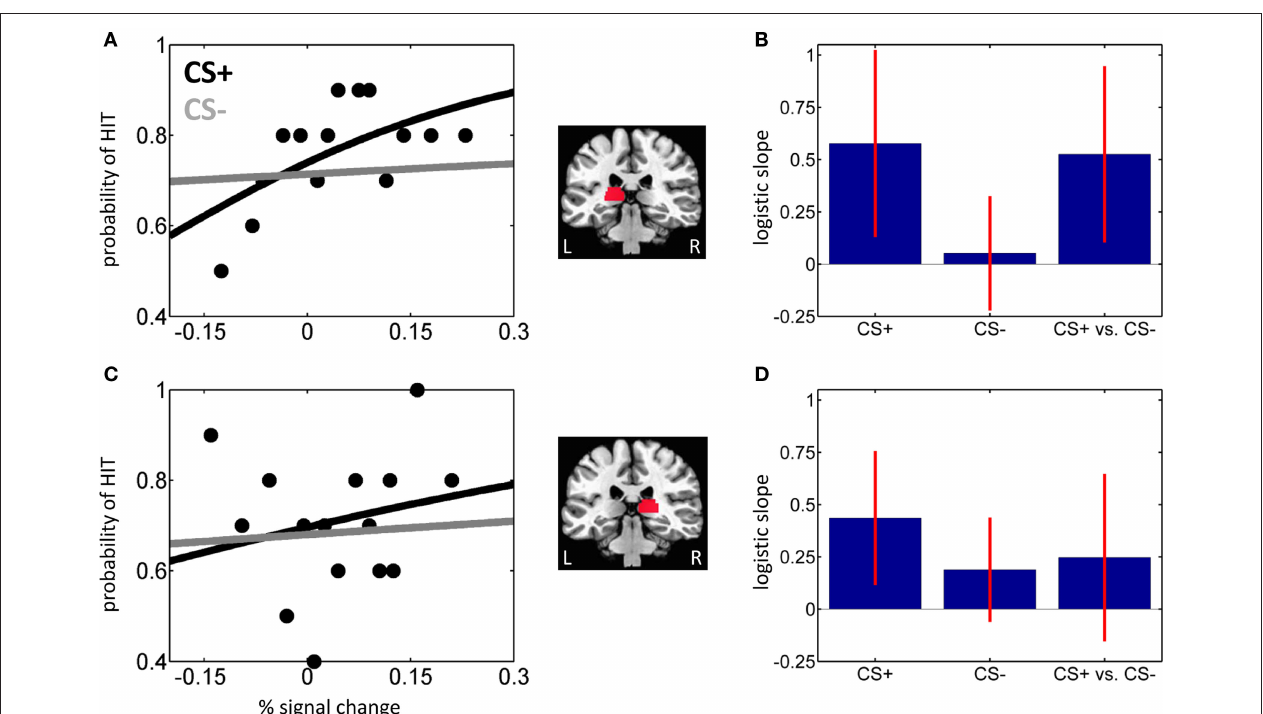
Figure 3 | Trial-by-trial analysis of hit vs. miss trials . (A,B) Left pulvinar. (A) Logistic regression analysis of evoked responses in the left pulvinar ROI as a function of affective significance (CS + and CS − ) for a sample individual. The slope of the logistic fit indicates the strength of the predictive effect. For clarity,